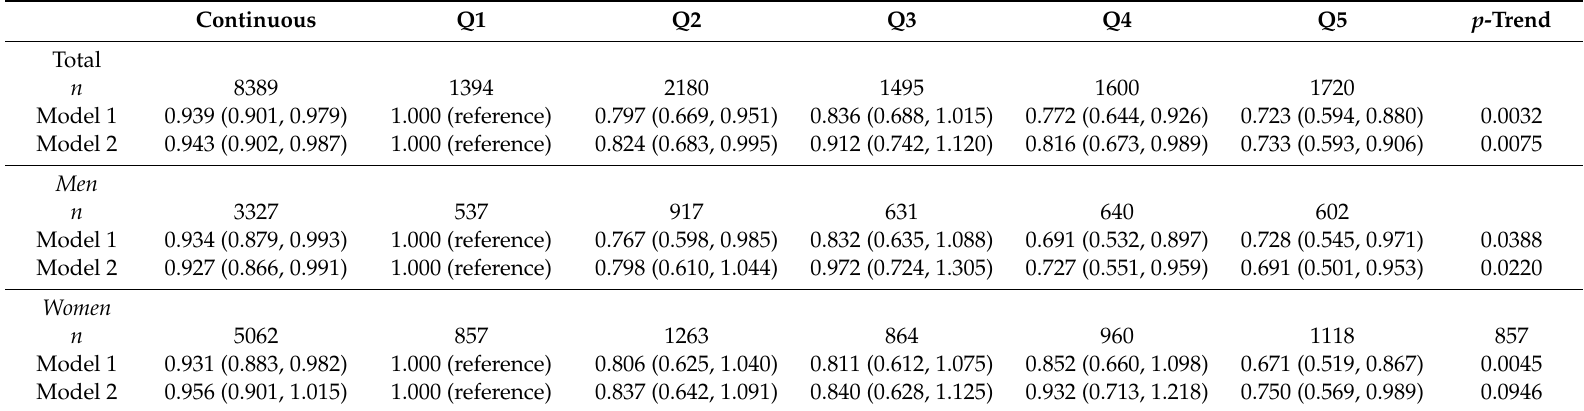
Table 4. Odds ratios and 95% confidence intervals for quintiles (Q1–Q5) of high blood pressure based on the mRFS. Continuous Q1 Q2 Q3 Q4 Q5 p